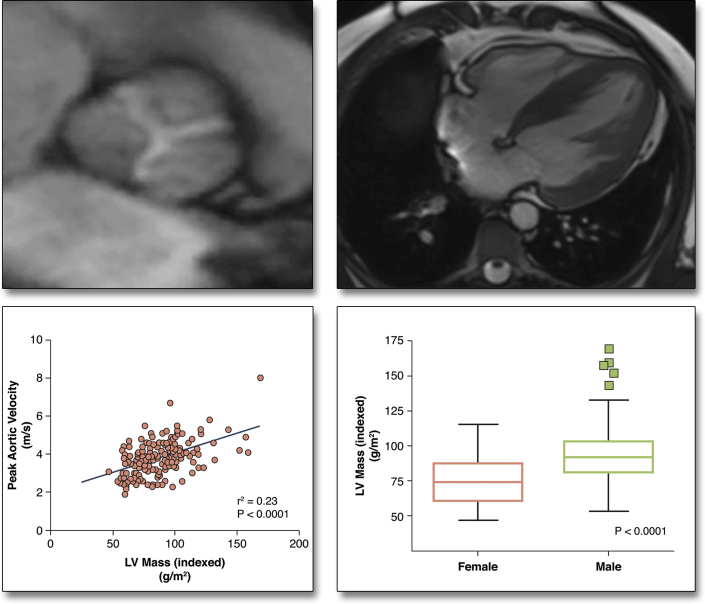
Factors Governing the Magnitude of the Hypertrophic Response in Aortic StenosisOnly a modest correlation between the severity of valve narrowing and the magnitude of the hypertrophic response was observed. The other predictor of left ventricular (LV) mass index on multivariate analysis was sex, with men having more hypertrophy than women.